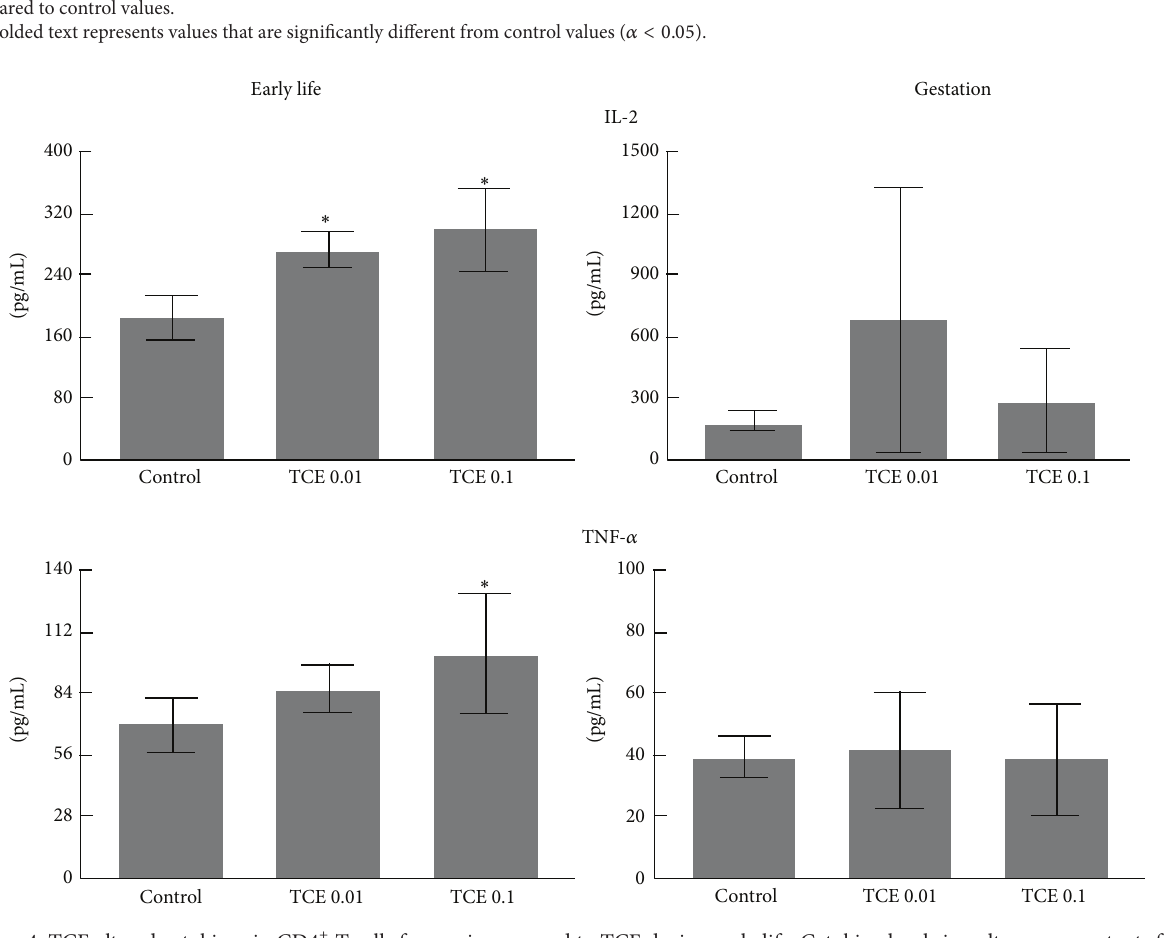
Figure 4: TCE altered cytokines in CD4 + T cells from mice exposed to TCE during early life. Cytokine levels in culture supernatants from CD4 + T cells prepared as described in Figure 4 were examined. ∗ Significantly different ( 𝛼 < 0.05 ) compared to control